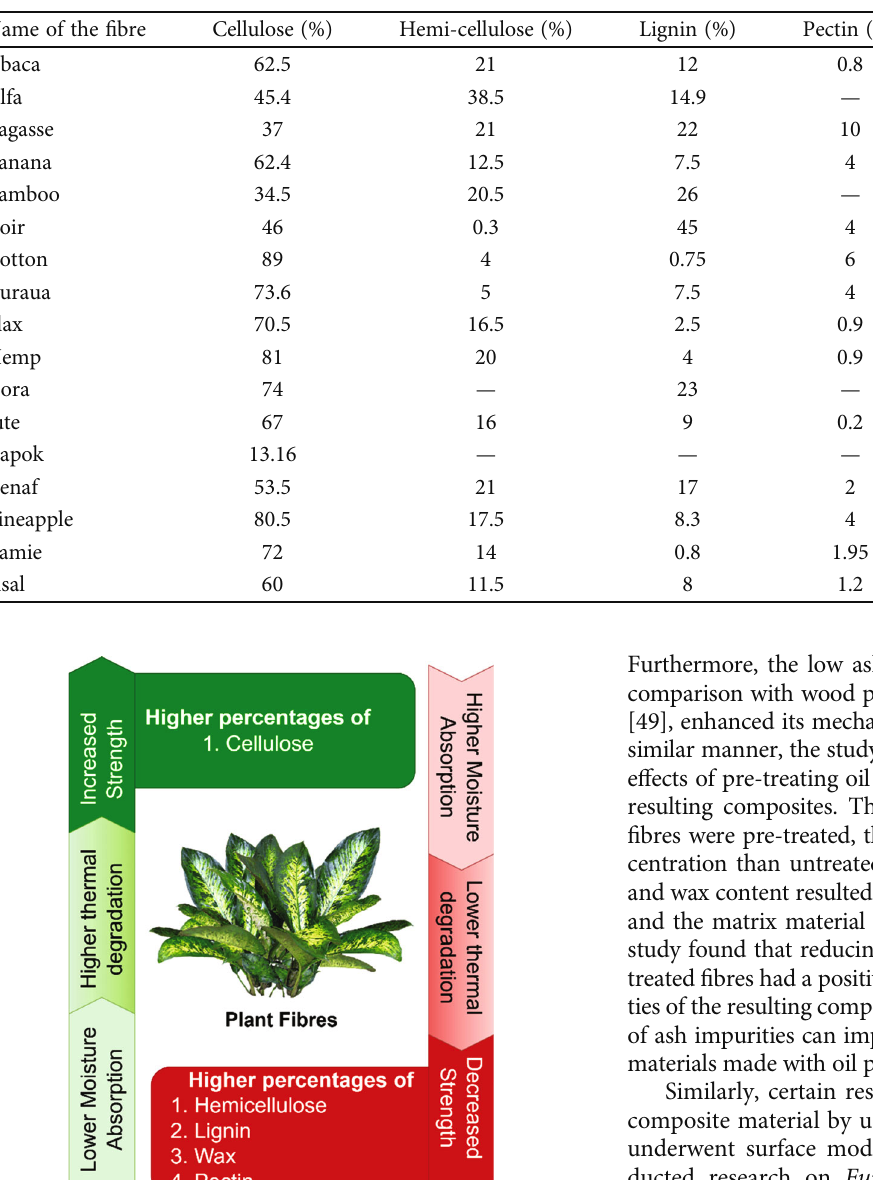
Table 2: Chemical constituents of various lignocellulose fi bres.